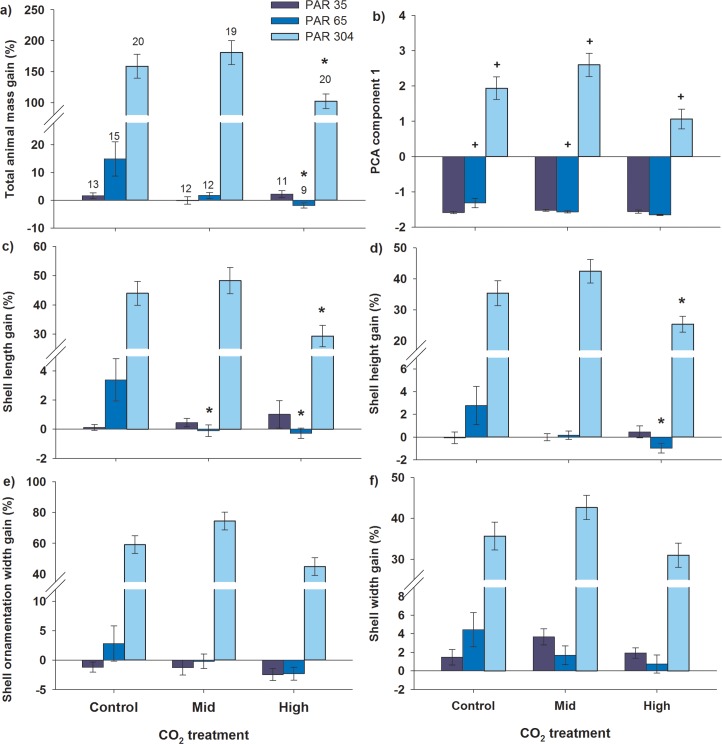
Influence of elevated CO2 and light on giant clam growth.Effects of CO2 and PAR on juvenile fluted giant clam growth in a) total animal mass, b) principle component analysis (PCA) component 1 (i.e. all shell linear dimensions), and individually, c) shell length, d) shell height, e) shell ornamentation width, and f) shell width gains. Numbers of replicates are the same for each graph and are shown above the bars in a). *denotes a significant difference from the control at each light level (for a, c-f). +denotes a significant difference from the PAR 35 control-CO2 level in PCA component 1 (for b). Error bars represent ±1 s.e.